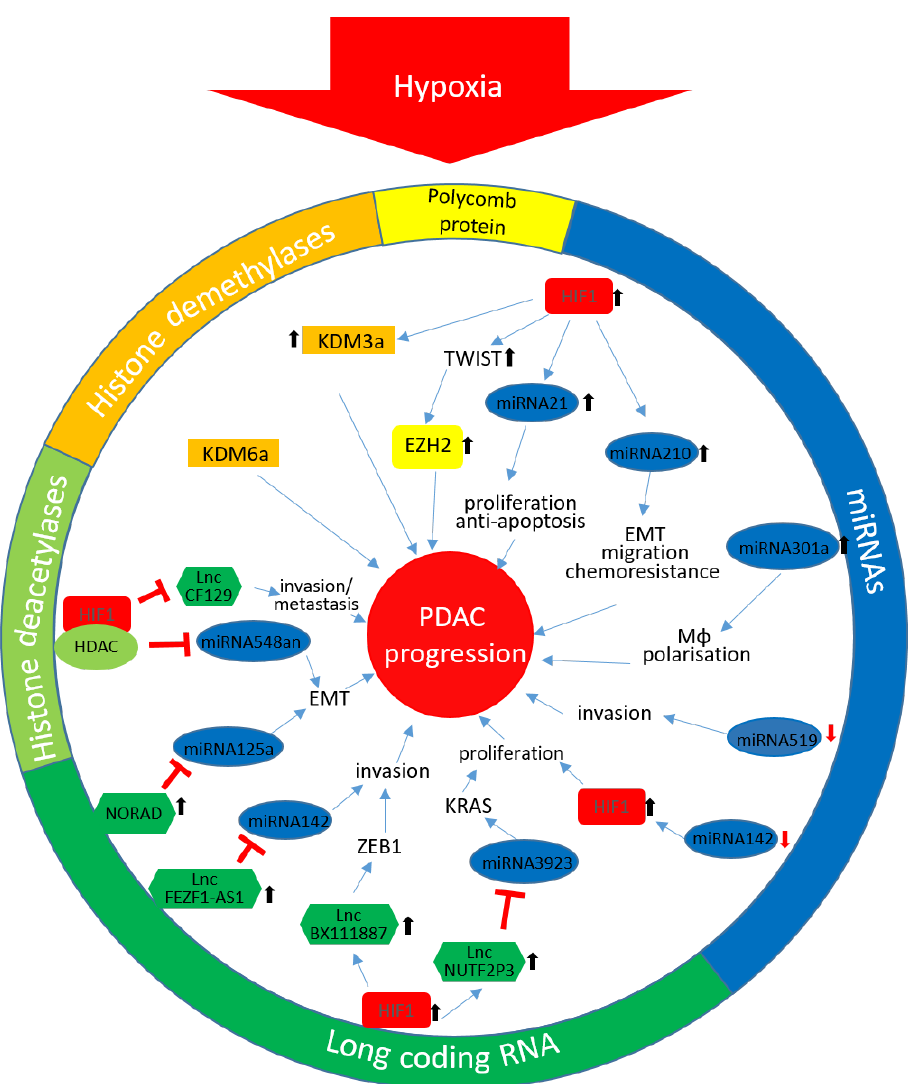
Figure 1. Hypoxia-mediated epigenetic changes in PDAC: The different colours reflect the affiliation to the in the circuit stated coloured epigenetic mechanism. ↑ enhanced expression; ↓ down-regulated expression. HIF-1α, Hypoxia inducible factor 1α; KDM3, lysine-specific demethylase 3; EZH2,